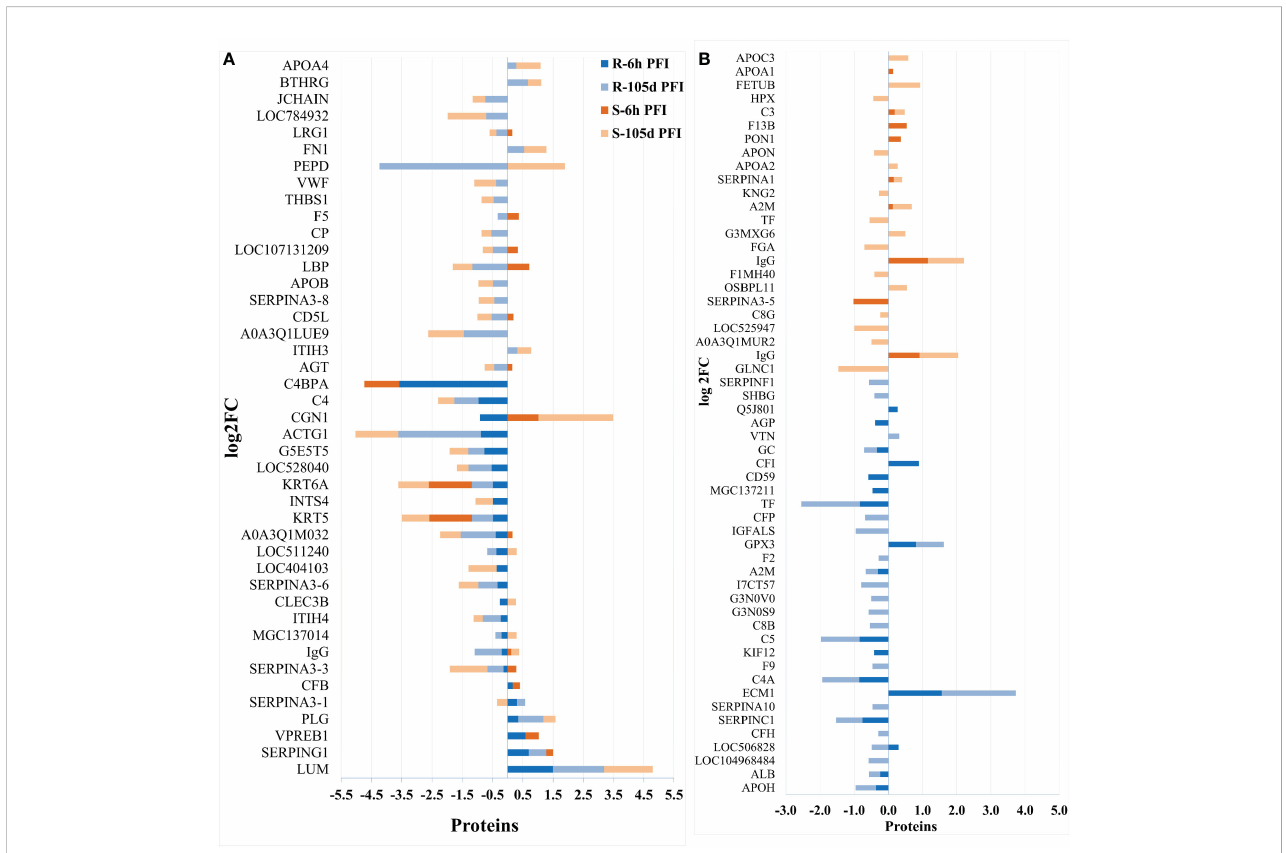
fi brinogen alpha (FGA; F6QND5) and kininogen 2 (KNG2;